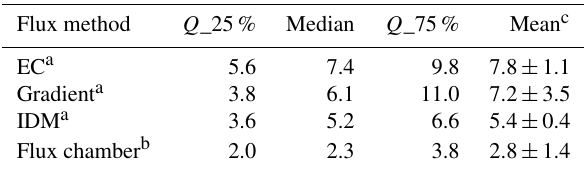
Table 1. Summary of CH 4 fluxes (gm − 2 d − 1 ) in this